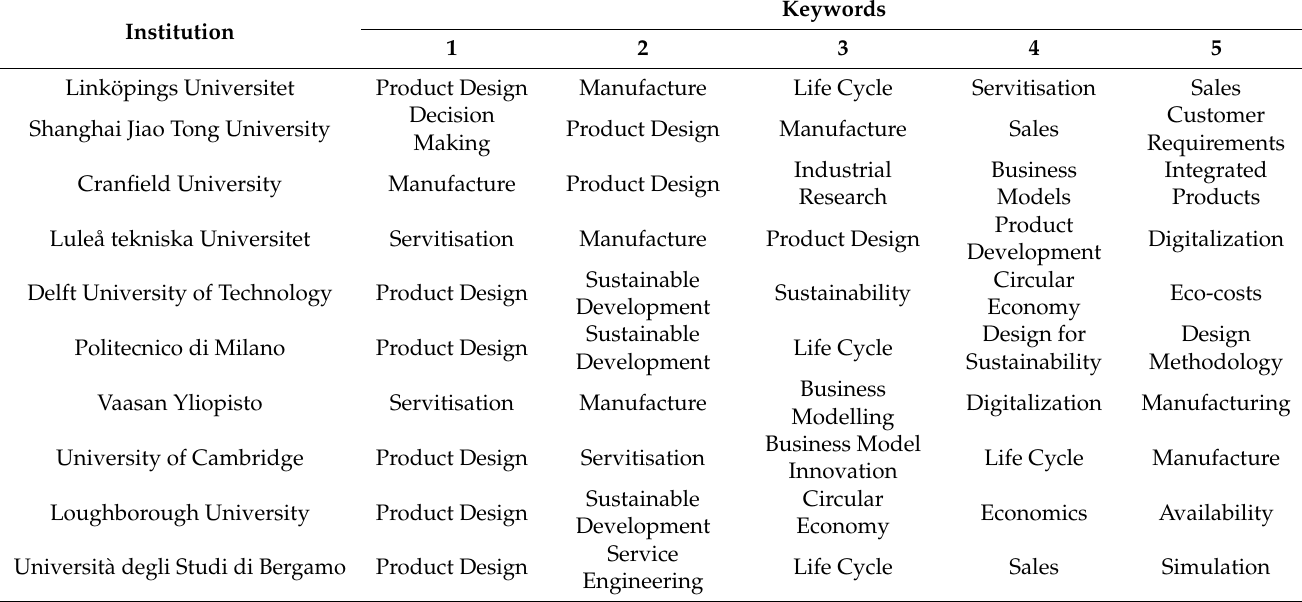
Table 12. Top five keywords for the top ten